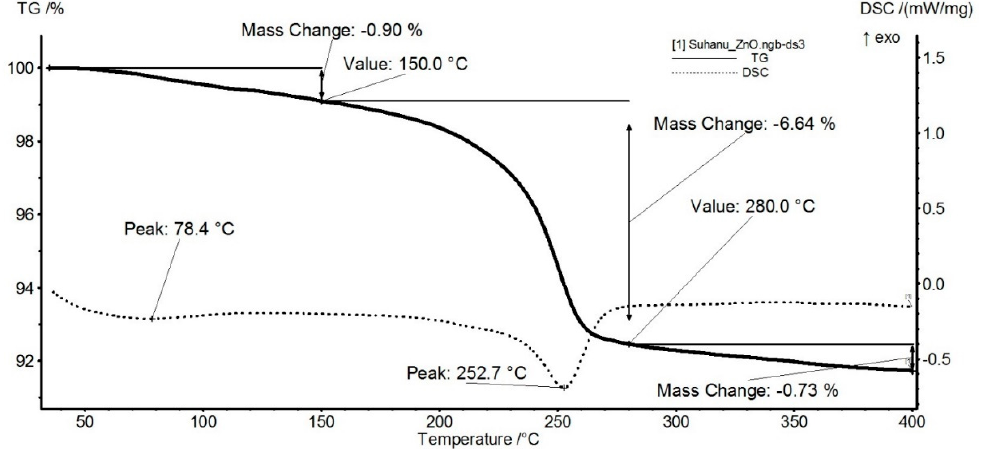
Figure 4. Thermogravimetric analysis of ZnO.